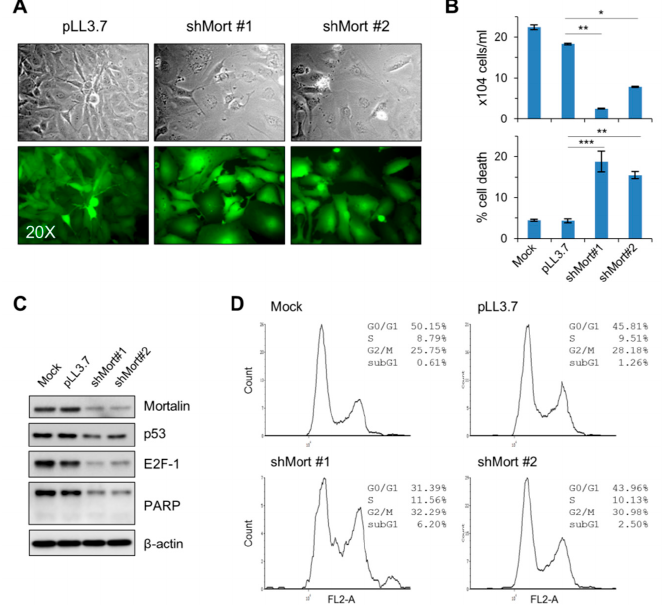
Figure 5. Mortalin knockdown induces growth inhibition in the FTC cell line, FTC133. ( A – D ) FTC133 cells were infected with pLL3.7 lentivirus expressing two different shRNAs that target mortalin mRNA (shMort #1 and shMort#2). ( A ) Green fluorescent protein expression indicates infection efficacy. ( B ) Trypan blue exclusion analysis of live and dead cells at infection day 4 (mean ± SD, n = 3), * p < 0.05; ** p < 0.005. ( C ) Western blot analyses of total cell lysates harvested at day 4. β -actin is the control for equal amounts of protein loading. ( D ) Cell cycle analysis at infection day